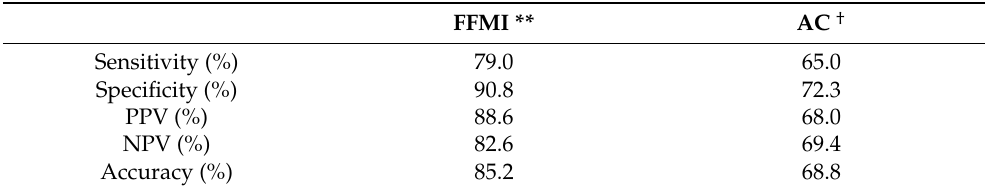
Table 2. Statistical evaluations of developed cutoff values for the FFMI and AC to discriminate the cutoff value for the SMI according to AWGS * in the validation group.